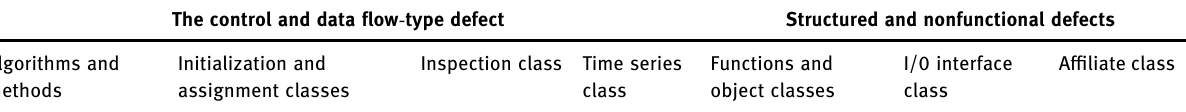
Table 2: Software defects library The control and data fl ow - type defect